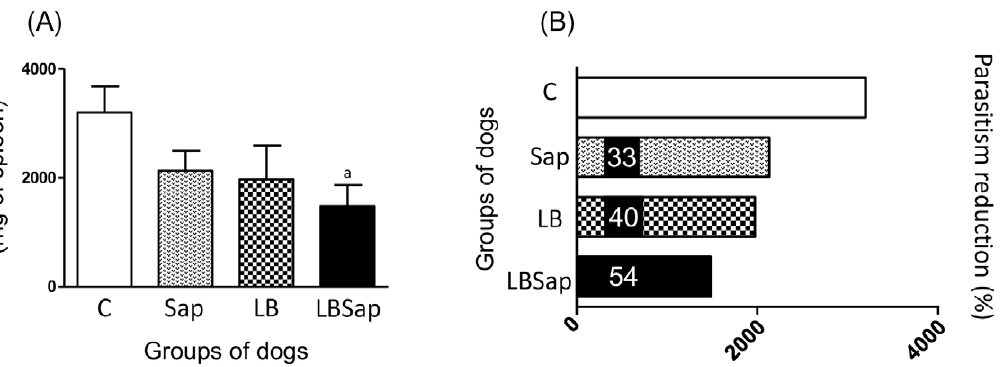
Figure 5. Quantification of parasite burden in spleen samples at 885 dac (days after challenge with L.infantum plus SGE) for vaccinated groups: C (control; white); Sap (saponin; white with weak hatched); LB (killed L.braziliensis vaccine; white with strong hatched); LBSap (killed L.braziliensis vaccine plus saponin; black). (A) The quantification of amastigote forms of Leishmania/ mg of spleen using real time PCR with specific primers for a single-copy gene of DNA polymerase of Leishmania infantum . (B) Parasitism reduction (%) in Sap, LB and LBSap in comparison with the control C group. Results were plotted representing median values for each group. Significant differences ( p , 0.05) between the LBSap and the control C group are represented by the letter a.